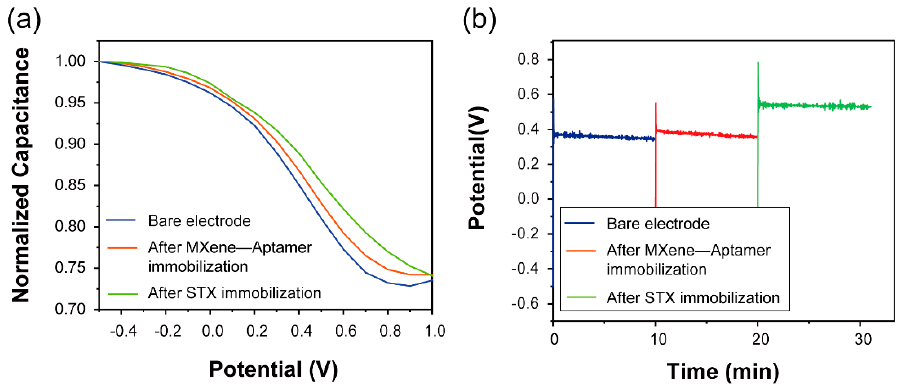
Figure 3. ( a ) C-V curves and ( b ) ConCap measurements (working point 2.77 nF) of bare electrodes, MXene-Aptamer immobilization, and 100 nM STX immobilization. MXene-Aptamer immobilization, and 100 nM STX